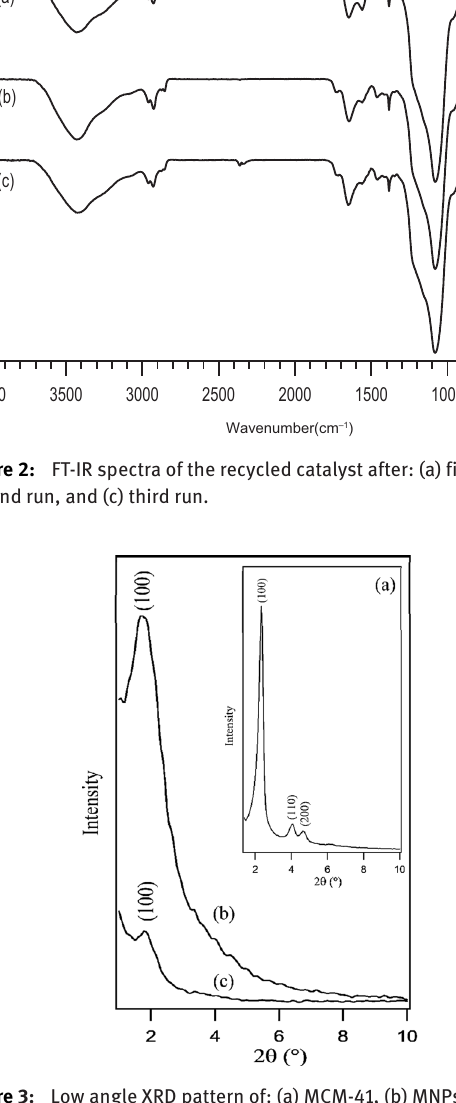
Figure 4: High angle XRD pattern of: (a) MNPs, (b) MCM-41, (c) MNPs@MCM-41, and (d) MMNP.